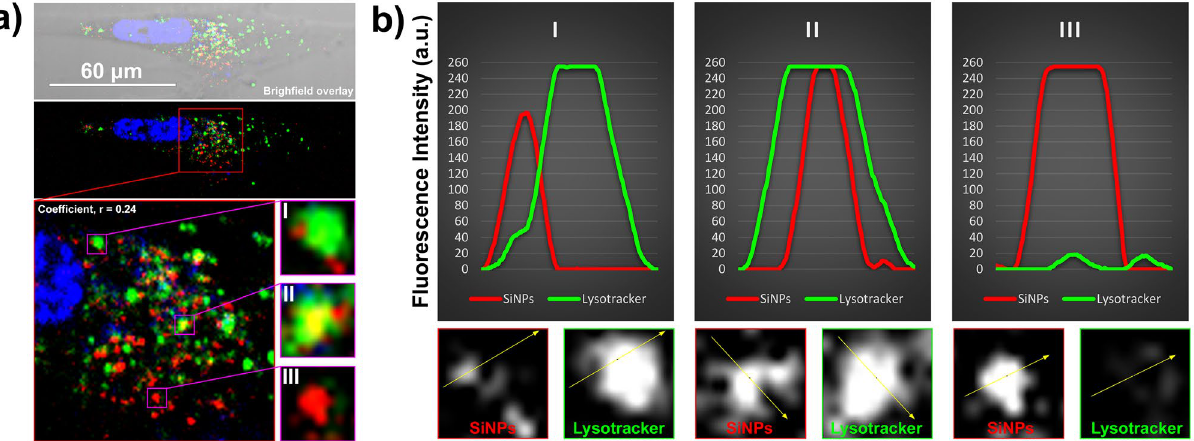
Figure 5. Co-localization of 200 nm SiNPs with lysotracker inside senescent cells. ( a ) Live imaging of senescent cells using CLSM. Staining with Hoechst 33342 (blue) and lysotracker (green) shows the nucleus and acidic cell compartments, respectively, in the same confocal plane as SiNPs (red). Colocalization analysis found overlap between lysotracker and SiNPs for the cell in the image with a Pearson’s correlation coefficient, r = 0.24. SiNPs and their relationship to lysotracker are denoted as I, II, and III and described further in the main text. ( b ) Quantification of the fluorescence images shown in ( a ) using a line analysis. The fluorescence channels were first split using Image J software and transformed to binary formats. The signals along the yellow line drawn for examples I, II, and III were plotted as overlaid histograms.